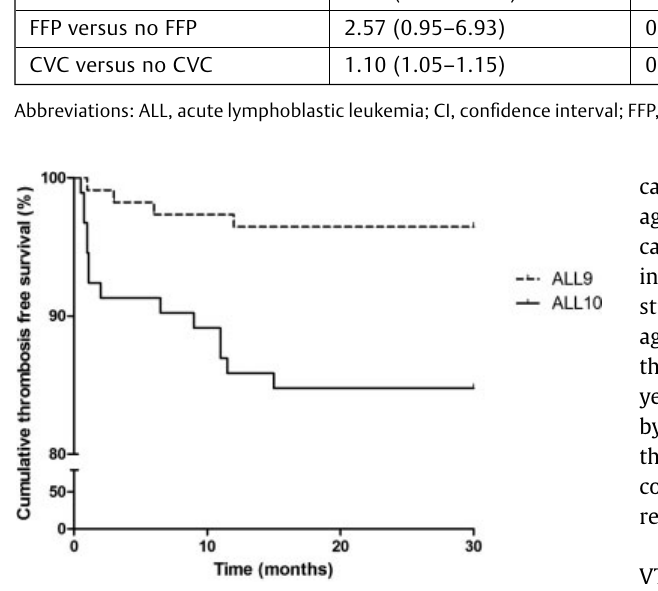
Fig. 4 Cumulative venous thromboembolic disease-free survival of children treated according to the DCOG ALL-9 and ALL-10 treatment protocol. ALL, acute lymphoblastic leukemia; DCOG, Dutch Childhood Oncology